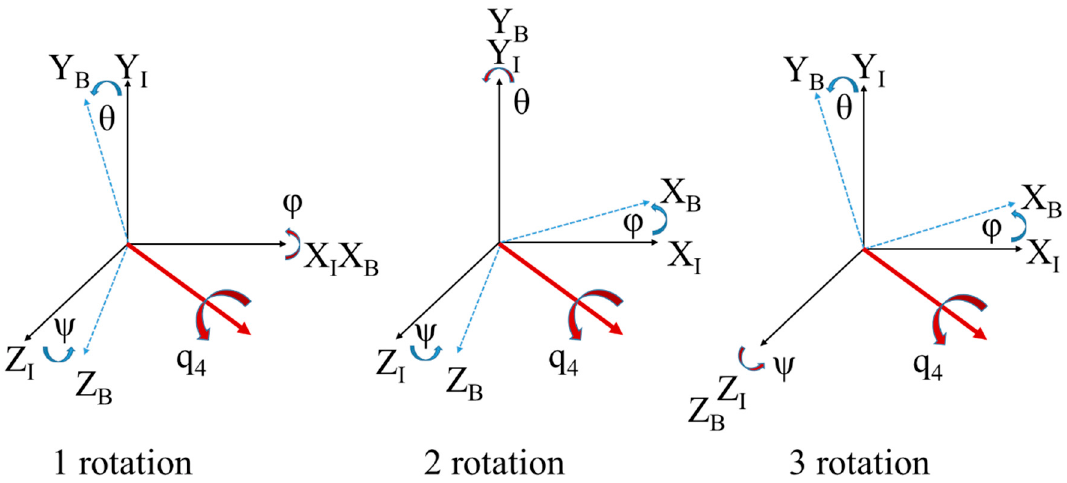
Figure 2. Execution of a 3-2-1 rotation from C A to C B (left to right); blue-dotted arrows denote angle rotations. A direct rotation from C A to C B can be made about the Euler Axis, q 4 in red. The set of three rotations may be depicted as four rectangular parallelepipeds, where each contains the unit vectors of the corresponding reference frame [29].